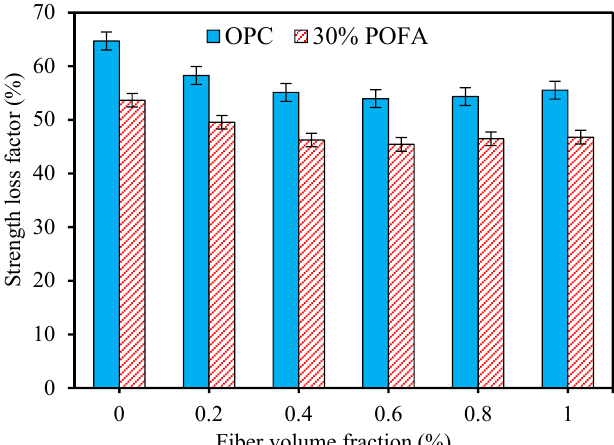
Figure 15. The effects of WPFT fibers on the strength loss factor of concrete mixtures exposed to a H 2 SO 4 solution.